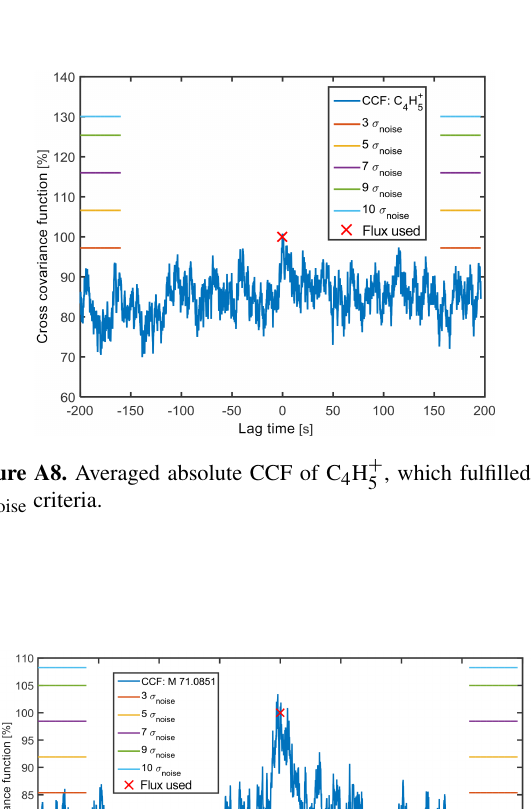
Figure A4. Thirty-minute normalized cross covariance function of C 3 H 7 O + from 15 June 2012, 14:15. No clear maximum or mini- 1 mum can be seen around 0s lag time. The red lines at the corners of the plot indicate the average noise, while the cyan lines are the 3 σ noise threshold (in the legend the 62% represents just the 3 σ noise , while in the plot it is added to the mean noise).